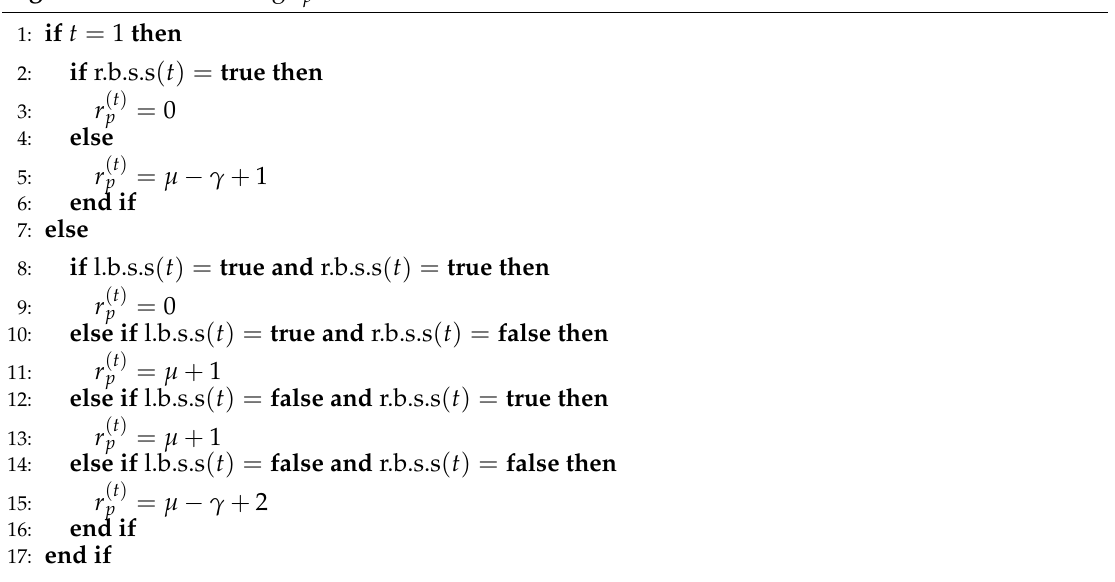
Algorithm 2 Determining r